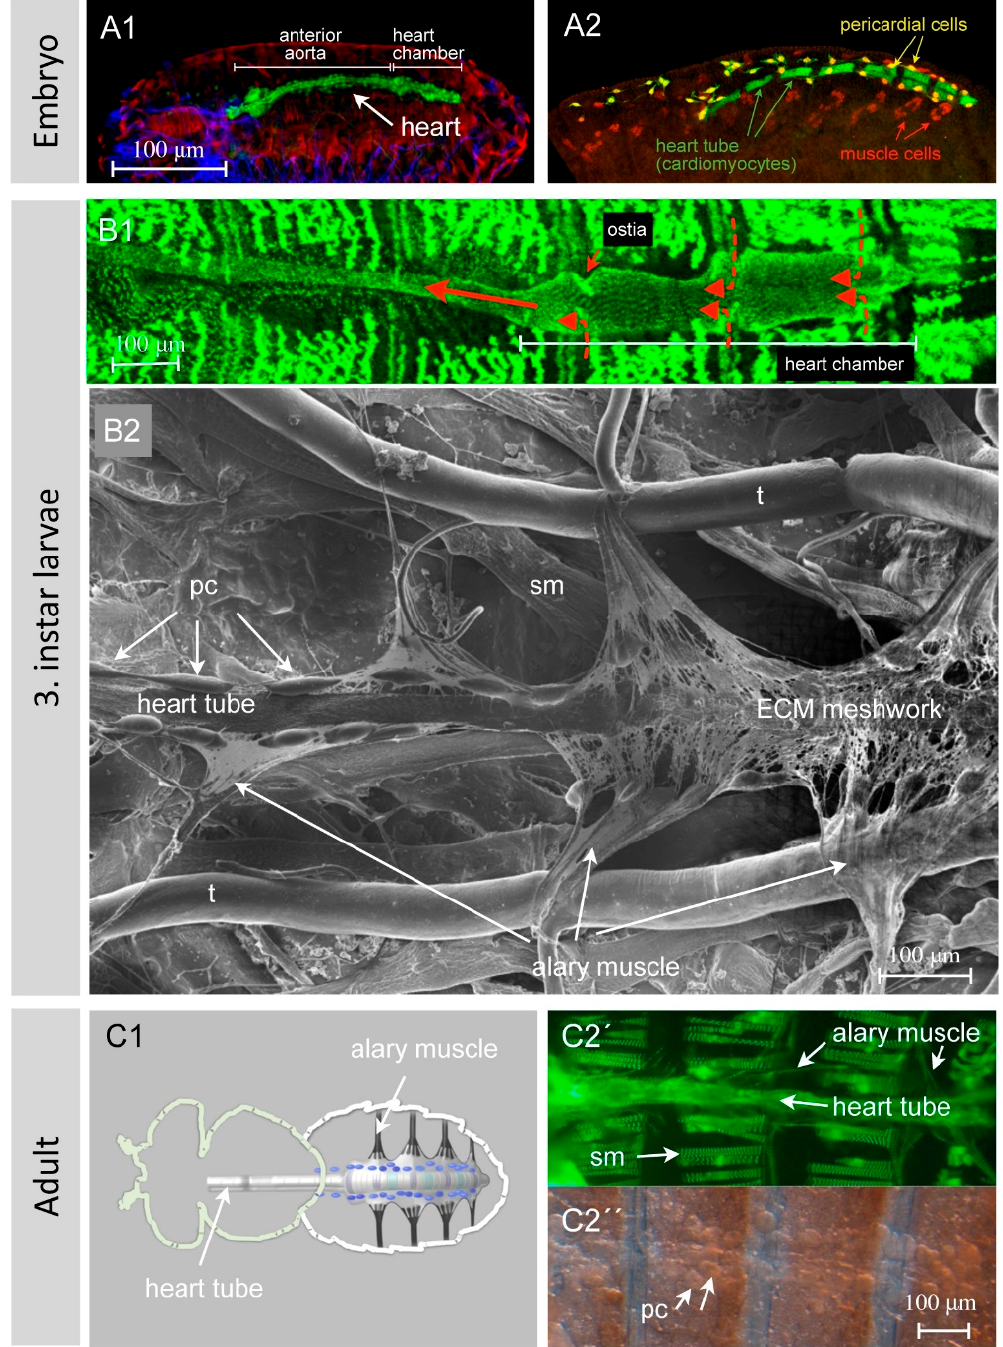
Figure 2. The Drosophila heart at different developmental stages: ( A1 ) and ( A2 ) show dorsoventral views of late wild-type embryonic hearts. Figure ( A1 ) shows an immunostained embryo with three different organ systems labeled. Heart cells were visualized with an anti-GFP antibody to detect GFP expressed under the control of hand -GFP (green channel); somatic muscles were visualized with an antibody recognizing β 3Tubulin (red channel); and the central nervous system with an anti-Mab22c10 antibody (blue channel). Further, ( A2 ) shows a late embryo stained for GFP (green channel) and Even-skipped (red channel). The Drosophila line used for the immunostaining harbors a GFP expressed under the control of a truncated hand enhancer ( hand -C 13-69 -GFP, Paululat personal communication), which drives GFP in all cardiomyocytes, except for those that form the ostia. Even-skipped is expressed in a subset of somatic muscles and pericardial cells. The pictures illustrate that the heart is composed of different cell types that can be distinguished by various molecular markers. Next, ( B1 ) shows a semi-intact third instar larva expressing Zasp52 tagged with GFP [17]. The posterior heart chamber, with its wider diameter, and the ostia, through which the hemolymph enters the heart, are visible. Red arrows indicate the directionality of hemolymph flow. The reporter line also labels the somatic muscles. Also, ( B2 ) shows a dissected wild-type third instar larva. Scanning electron microscope imaging was performed from the ventral side of the specimen; thus we look onto the ventral side of the larval heart, illustrating the heart with its alary muscles, pericardial cells and ECM network. Next, ( C1 ) provides a schematic illustration of the location of the heart in an adult fly. The heart cells are color-coded to distinguish the cell types: grey: cardiomyocytes, violet: ostial cells,